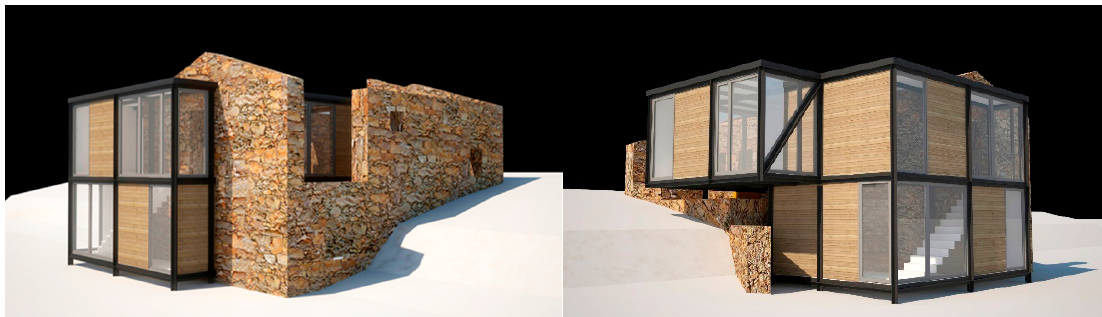
Figure 4. Three-dimensional images of the prototype: southeast and